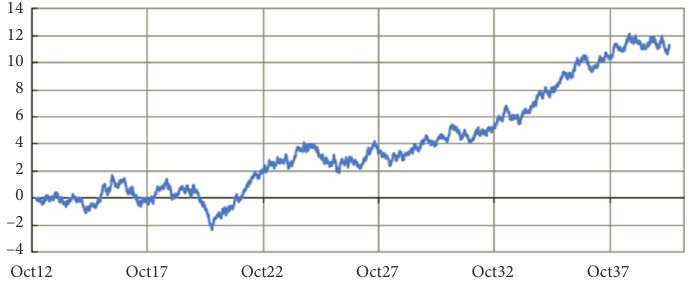
Figure 1. Random walk (source: Huggins and Schaller 2013:19)